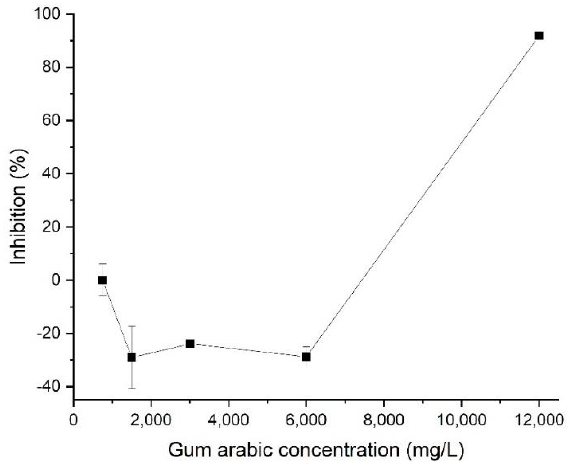
Figure 2. Inhibition of gum arabic in a 72 h exposure test.